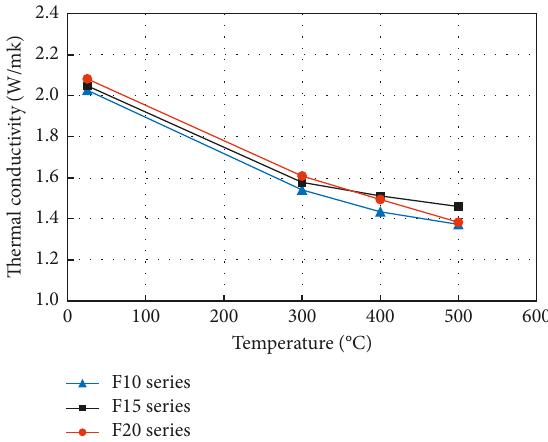
Figure 11: Comparison of thermal conductivities before and after six thermal